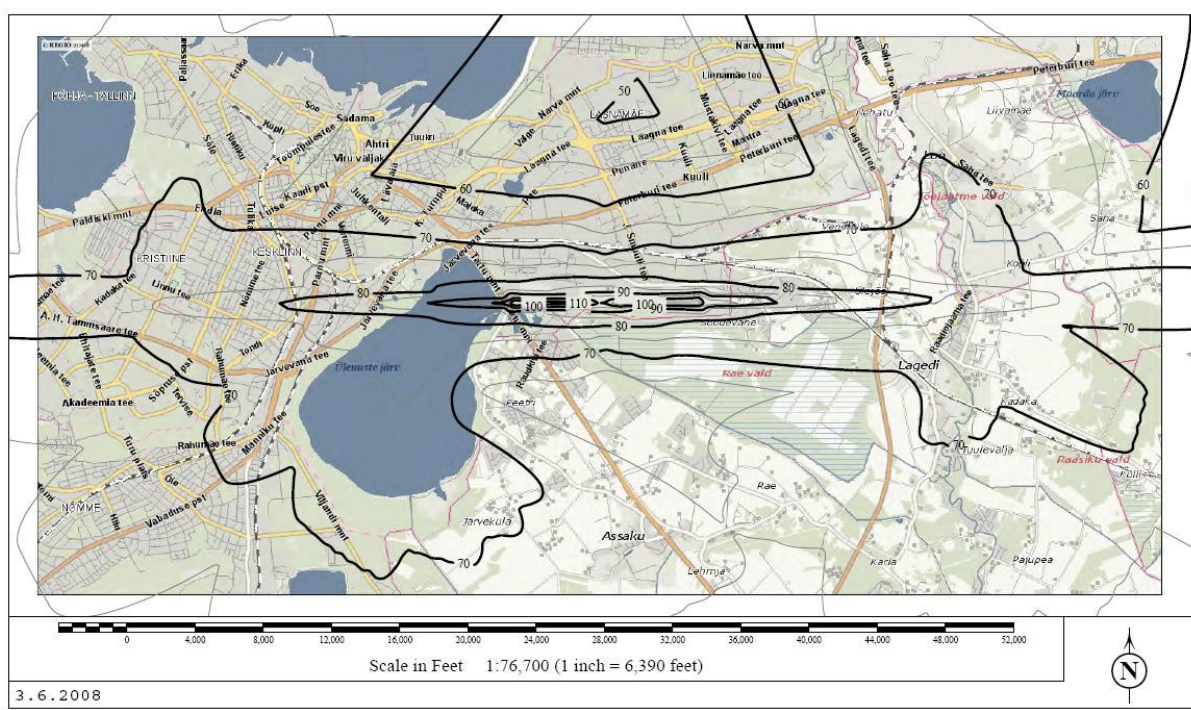
Fig 7. Tallinn Airport. Noise map according to Directive 2002/49/EC. LAmax (7-23) noise contours. 2006 average traffic